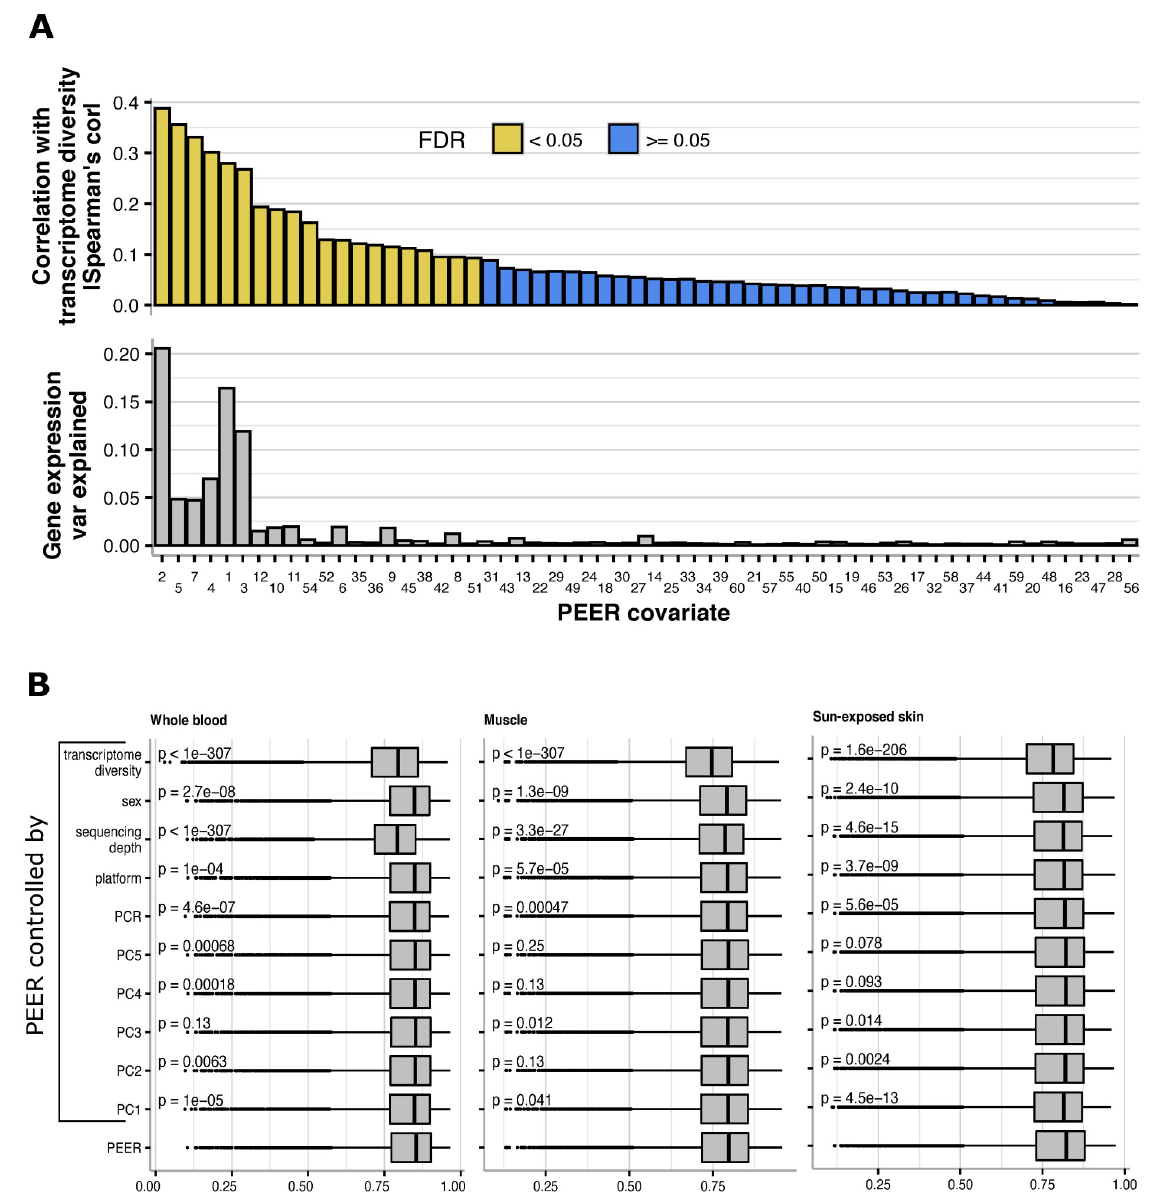
Fig 5. In GTEx, PEER covariates correlate with transcriptome diversity. A Top: Spearman correlation coefficients between transcriptome diversity values and the values of all PEER covariates obtained from the full GTEx blood expression matrix (see Materials and methods: Uniform processing) and colored by significance of correlation using BH-FDR. Bottom: Variance explained by each PEER covariate of the GTEx Blood full expression matrix (calculated using a PCA-based method; see Materials and methods: Variance explained of gene expression matrices). For all other GTEx tissues, see Fig D in S1 File. B Boxplots for three selected tissues whole blood, muscle, and sun-exposed skin, showing the distribution of variance explained values ( r 2 ) from linear regressions done on the expression of each gene using either intact PEER covariates, or the residuals of regressions performed on the same PEER covariates using the variables shown (controlled PEER rows, see Materials and methods: Gene expression variance explained by PEER accounted by transcriptome diversity and other covariates). Mann- Whitney tests against the intact PEER covariates were performed for each of the controlled PEER distributions and the corresponding p- values are shown.